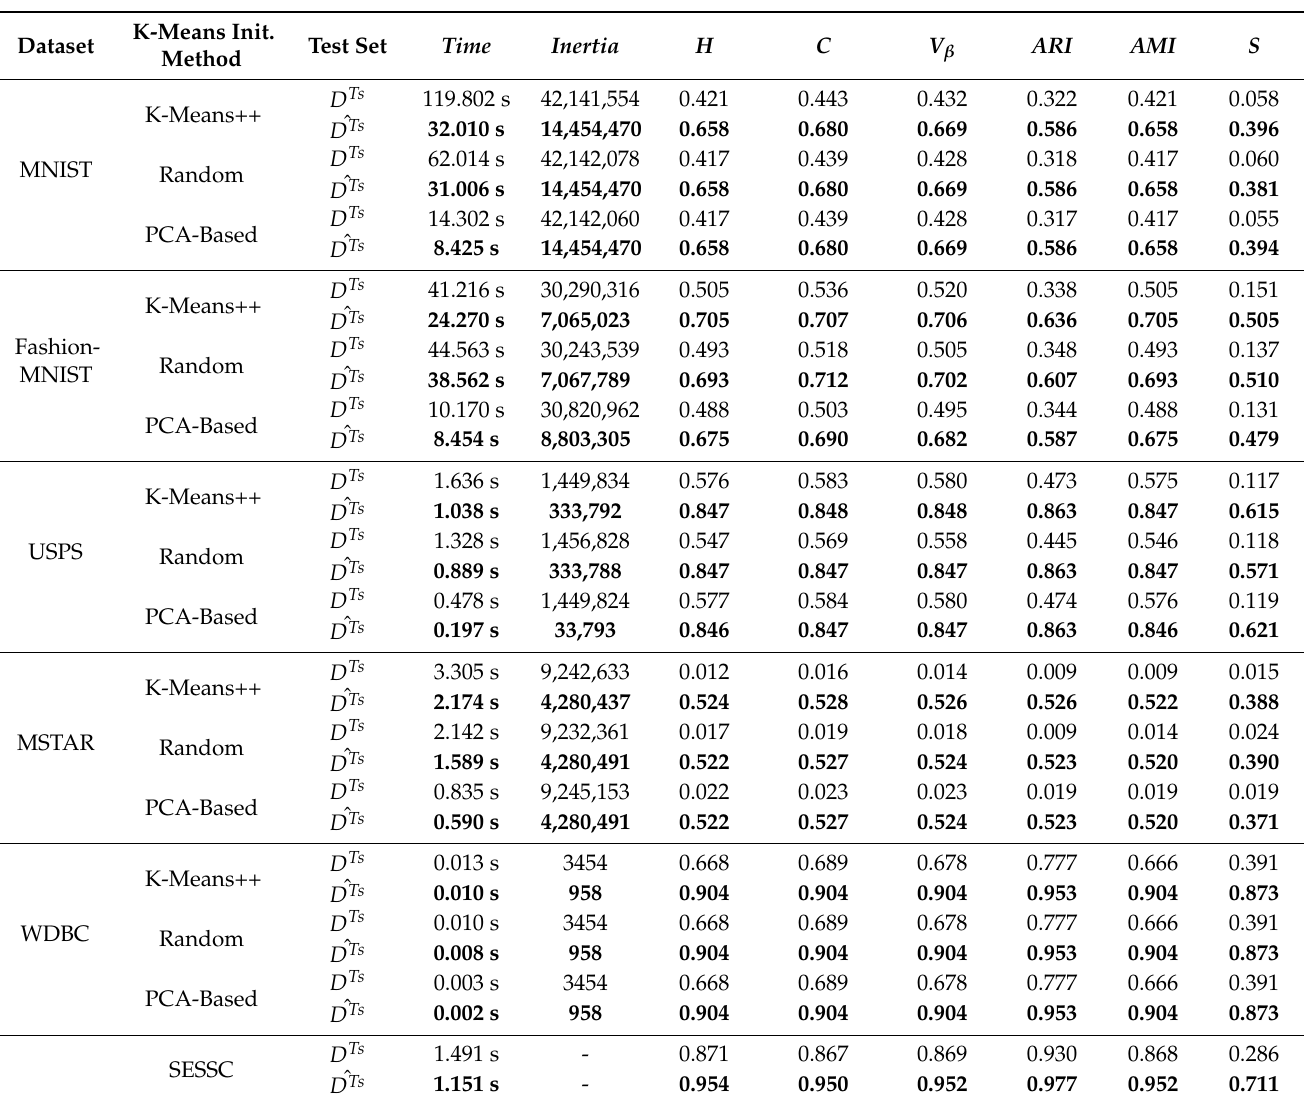
Table 3. Semi-supervised clustering performance evaluation results. Bolded values indicate the best results achieved in each metric. D Ts is the original unlabeled test set (without transformation) and ˆ D Ts is the transformed (using our model) unlabeled test